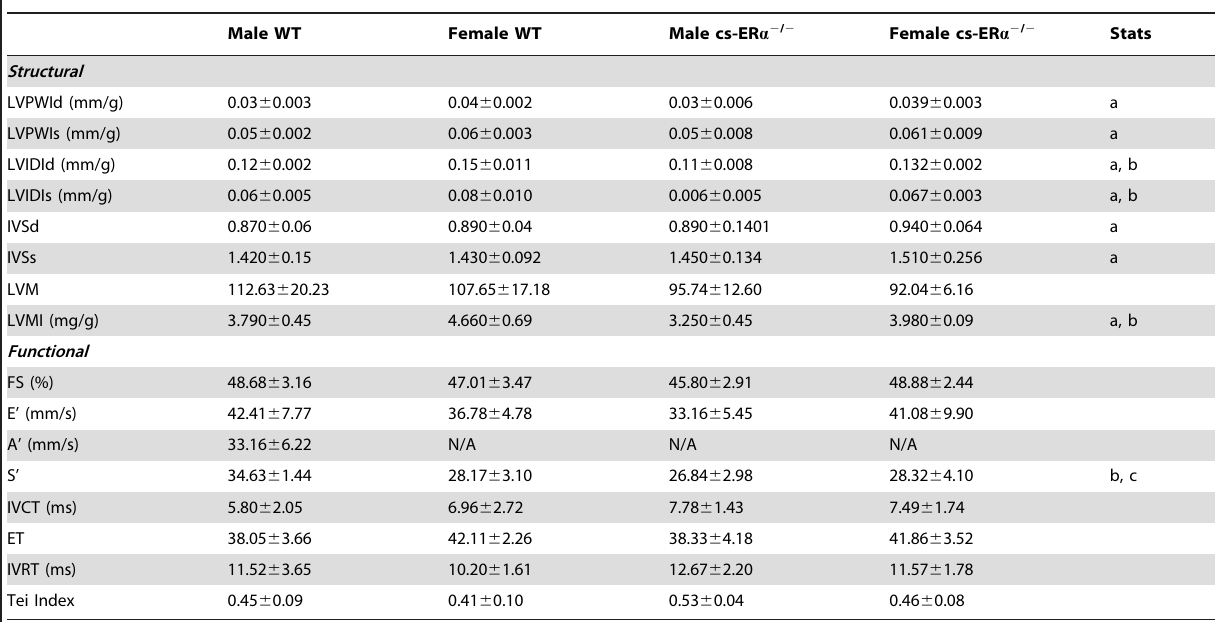
Table 1. Echocardiographic